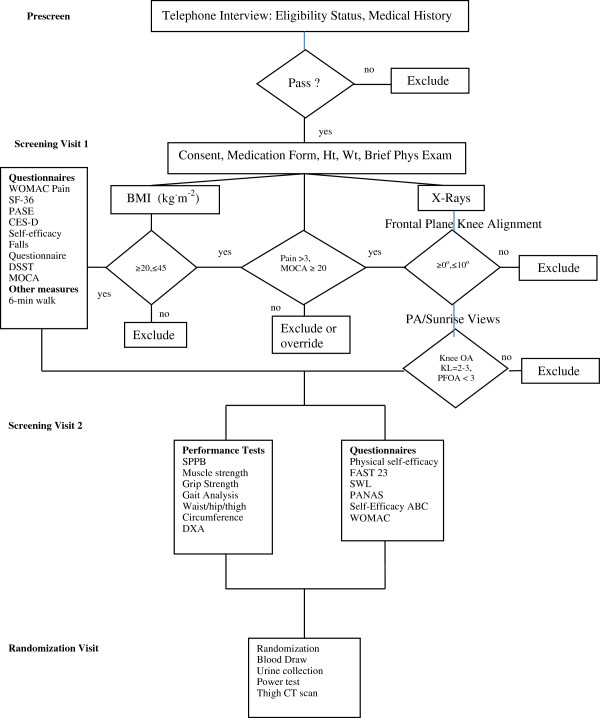
Participant eligibility and screening flow chart.